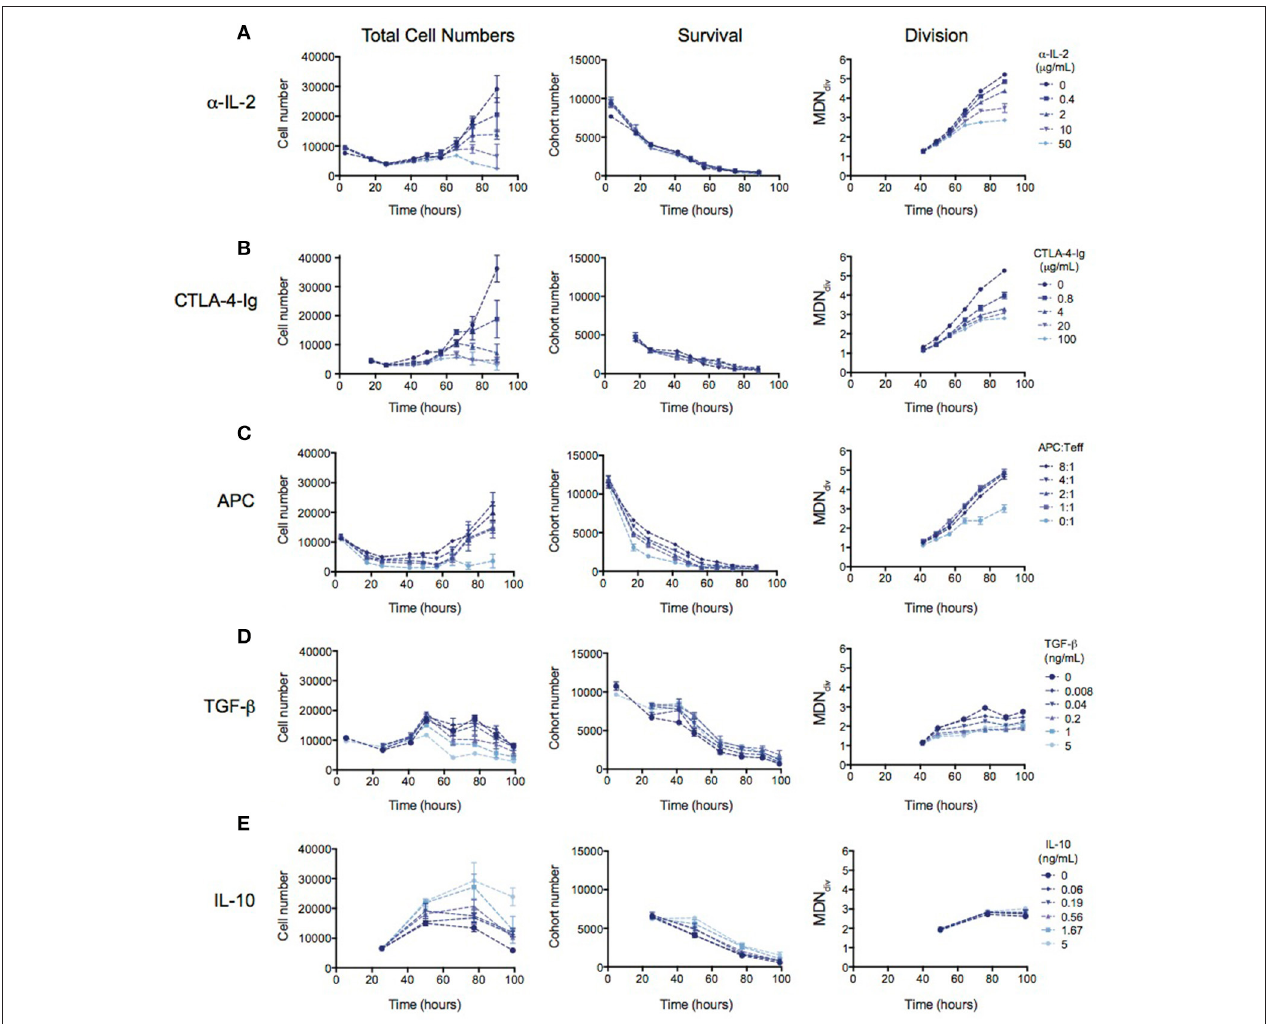
FIGURE 3 | The kinetic effects of Treg suppression may be mimicked by some, but not all, known mechanism of Treg action. Teffs were stimulated with irradiated splenocytes (APCs) and anti-CD3. (A) Titration of an anti-IL-2 blocking antibody (S4B6)—total cell number (left panel), cohort number (middle panel) and mean division number of divided cells (MDN div, right panel). Titration of (B) CTLA4-Ig, (C) APC number, (D) TGF- β and (E) Titration of IL-10. Data shown are mean + /– SEM of triplicate samples. One representative data set from two independent experiments is